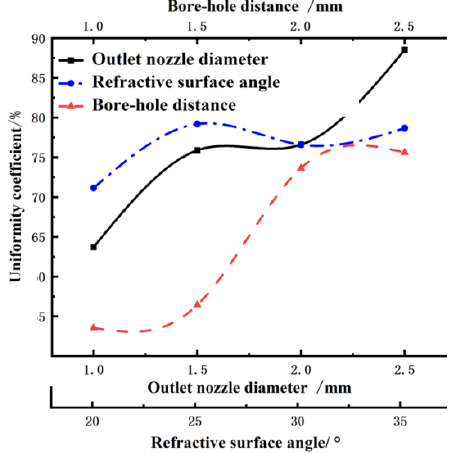
Figure 5. The influence of key structures on the uniformity coefficient.